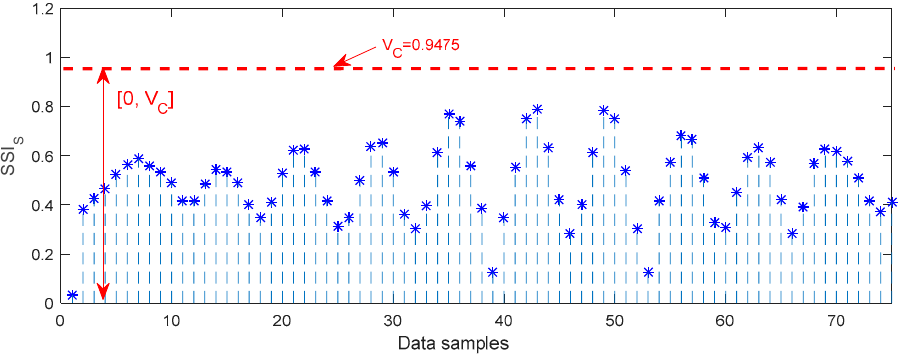
Figure 13. Upper and lower boundaries of the SSI S for characterization of the normal axle bearing vibration signal.